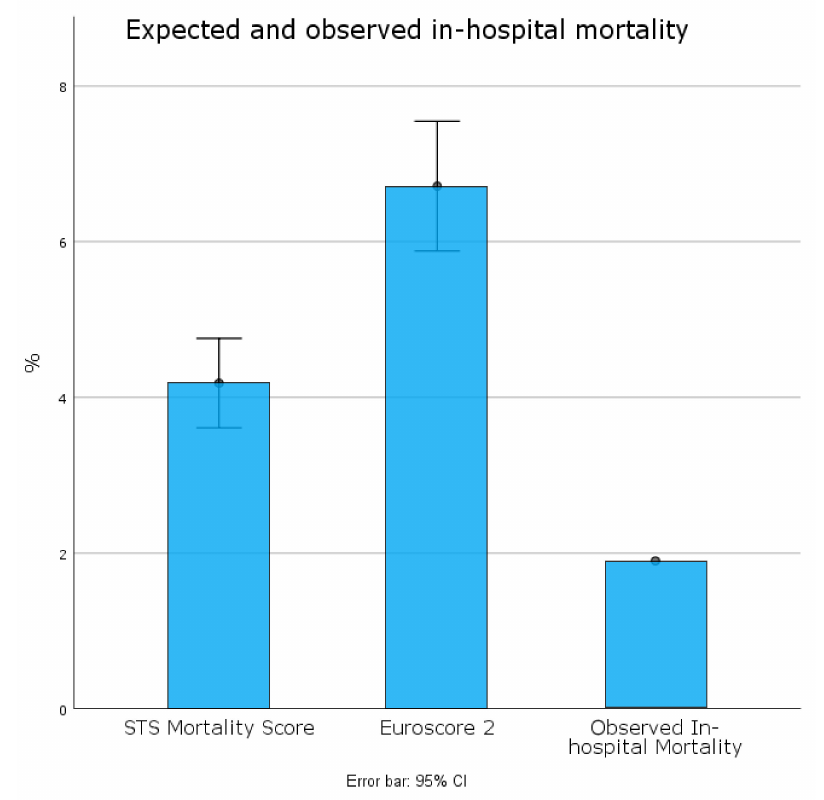
Figure 2. Expected and observed periprocedural mortality.